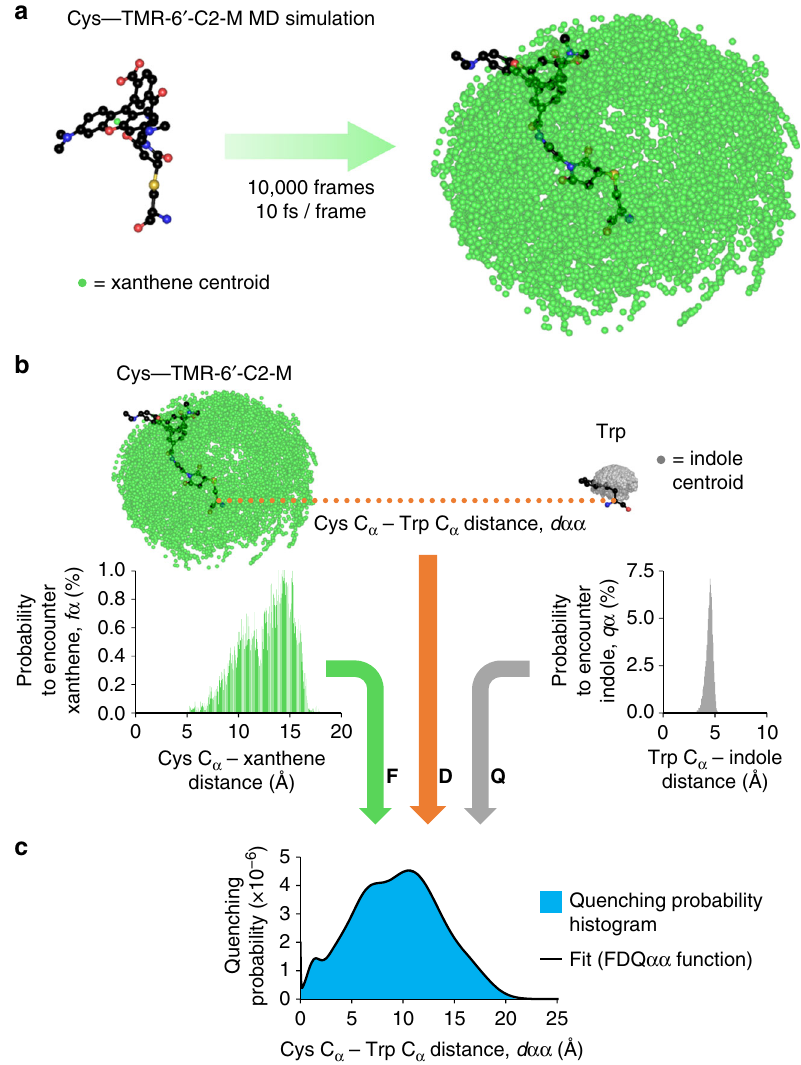
Fig. 3 Producing distance-dependent quenching functions for DEPET. a A Cys — TMR-6 ′ -C2-M conjugate was constructed and simulated using molecular dynamics (MD). The centroid of the fl uorescent moiety (xanthene) is shown as a green sphere. b A histogram for the probability to encounter xanthene a given distance from the Cys C α , f α , was constructed by binning Cys C α /xanthene distances following the MD simulation. The same method was used to calculate the Trp side-chain (indole, gray) probability as a function of distance from the Trp C α , q α . c Since indole quenches xanthene by contact 8 , the chance that they encounter each-other ( f α ∩ q α ) is the quenching probability, which was calculated for any distance ( d αα ) separating the C α atoms of the labeled Cys and the Trp (blue). This histogram was empirically fi t with a sum of exponential and Gaussian functions (black curve), subsequently used to extract distance information from DEPET data. The Fluorophore — Distance — Quencher (FDQ αα ) functions for the other TMRM fl uorophores are shown in Supplementary Figure 7; the FDQ αα parameters are in Supplementary Table 1. A similar exercise to correlate quenching probability to the distance between the Cys C α and Trp C β atoms (FDQ αβ ) is shown in Supplementary Figure 9; parameters in Supplementary Table